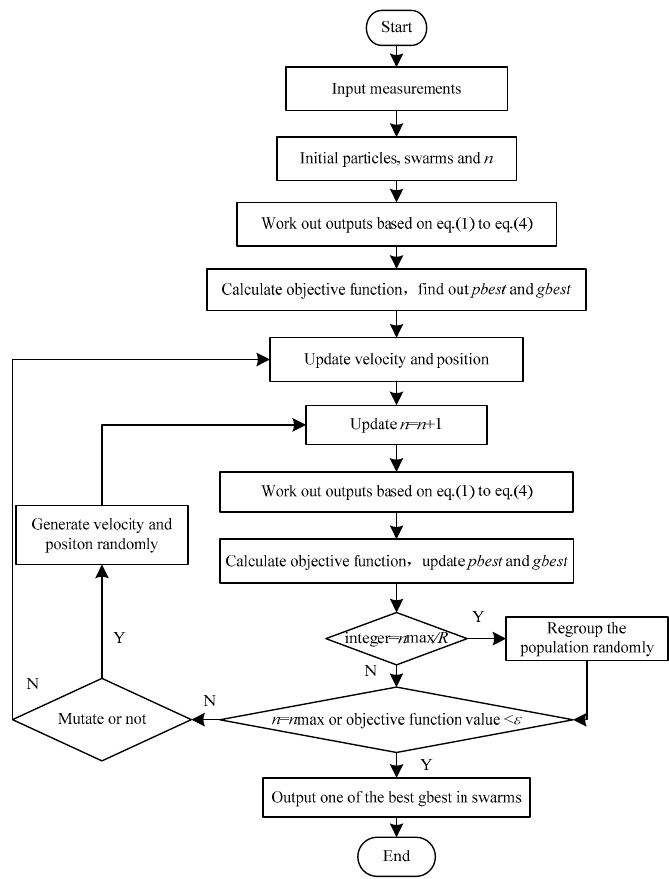
Figure 4. Flow chart of parameter identification based on dynamic multi ‐ swarm particle swarm optimizer (DMS ‐ PSO) algorithm.